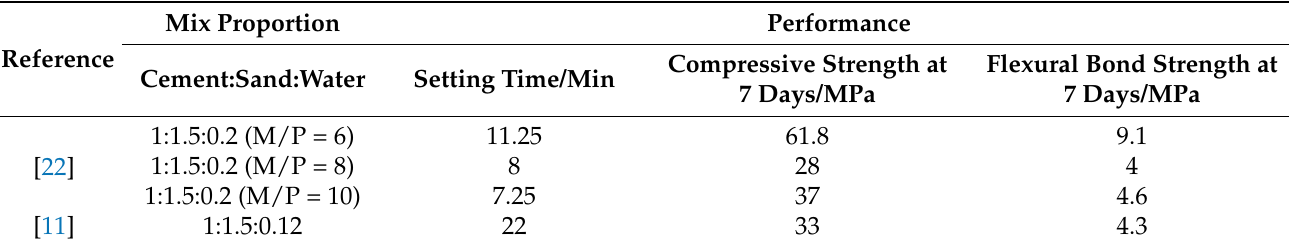
Table 6. Properties of Magnesium Phosphate mortar as repair